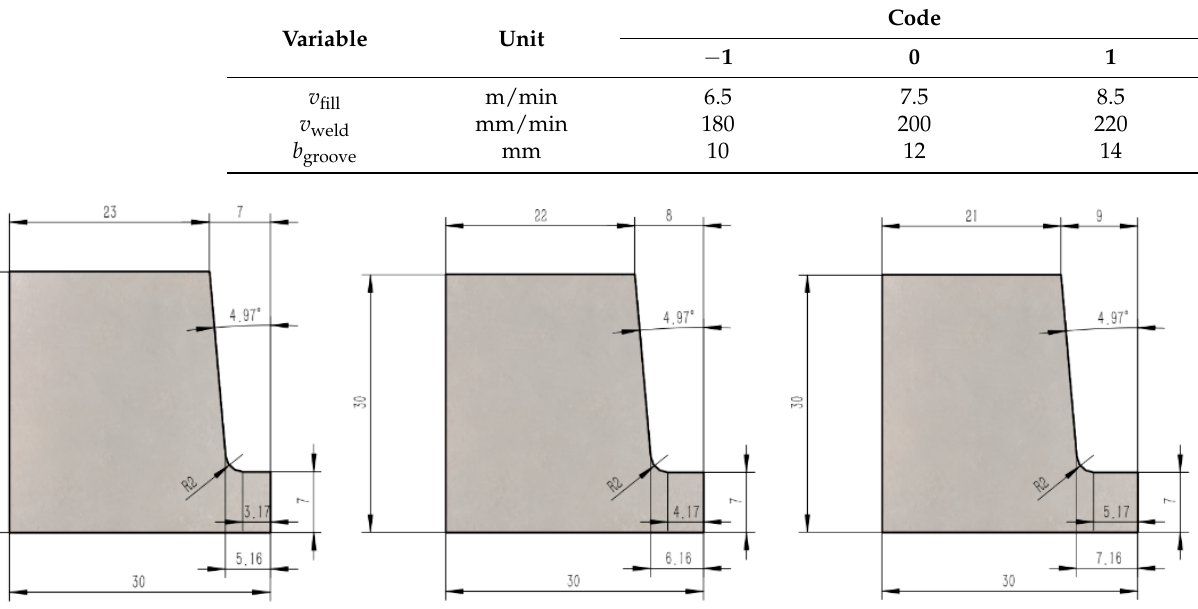
Figure 2. Grooves used in the Box–Behnken design.